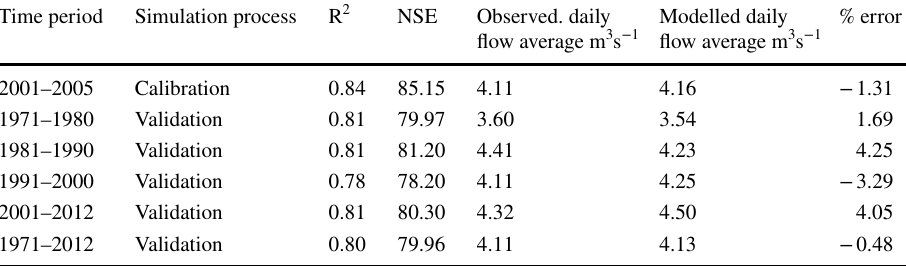
Table 2 Model calibration and validation over the 42 years period between